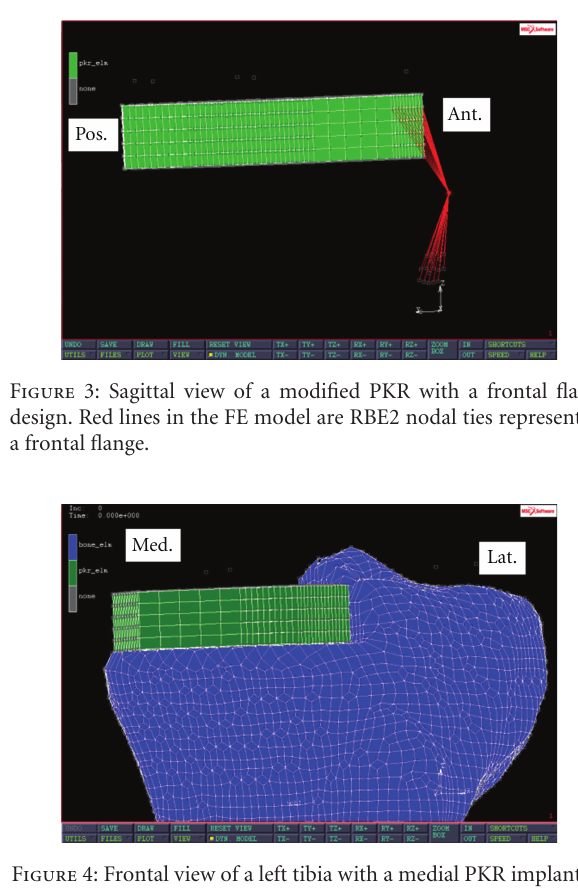
Figure 4: Frontal view of a left tibia with a medial PKR